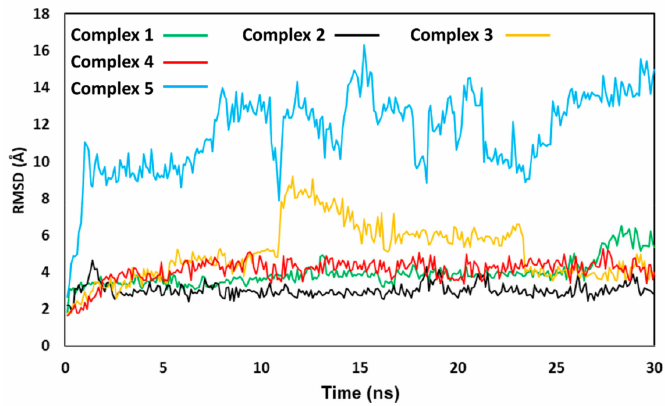
Figure 9. Molecular dynamics (MD) analysis of the 5 OC-p50 / p65 complexes. The reciprocal root-mean square deviation (RMSD) of the ligand disposition during the simulation, with respect to the initial docking pose, is shown for the complexes